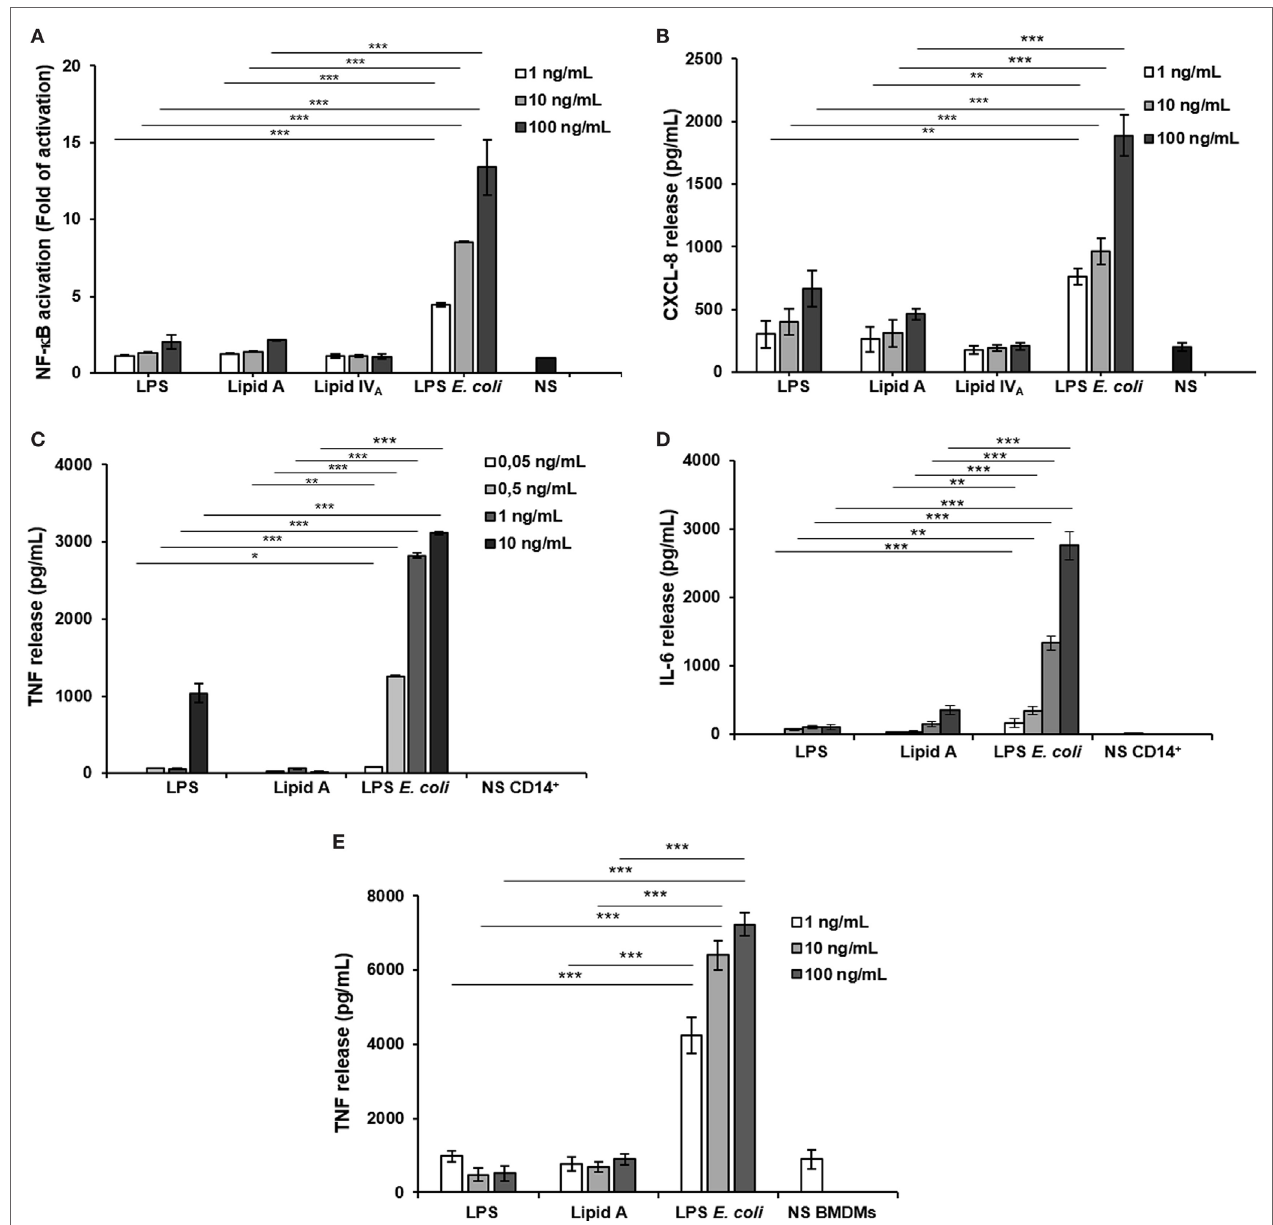
FigUre 2 | Analysis of immunopotential of Bradyrhizobium LPS/lipid A in HEK293 hTLR4 cell line, monocytes, and BMDMs. Activation of nuclear factor kappa B (a) and CXCL-8 production (B) in HEK 293 hTLR4/MD2-CD14 stimulated with Bradyrhizobium LPS/lipid A at the concentration of 1, 10, and 100 mg/mL for 6 h. Commercial hexa-acylated Escherichia coli LPS or synthetic lipid IV A were used at the same concentrations as positive and negative control, respectively. tumor necrosis factor TNF (c) and IL-6 (D) release in cell-free supernatants of monocytes stimulated with Bradyrhizobium LPS/lipid A at the concentration of 0.05, 0.5, 1, and 10 mg/mL for 12 h. Commercial hexa-acylated E. coli LPS was used at the same concentrations as control. TNF (e) production in BMDMs stimulated with Bradyrhizobium LPS/lipid A at the concentration of 1, 10, and 100 mg/mL for 6 h. Abbreviation: NS: not stimulated. Data are expressed as mean ± SD of three independent experiments in triplicate. * p < 0.05, ** p < 0.01, and *** p < 0.001, after Student’s t